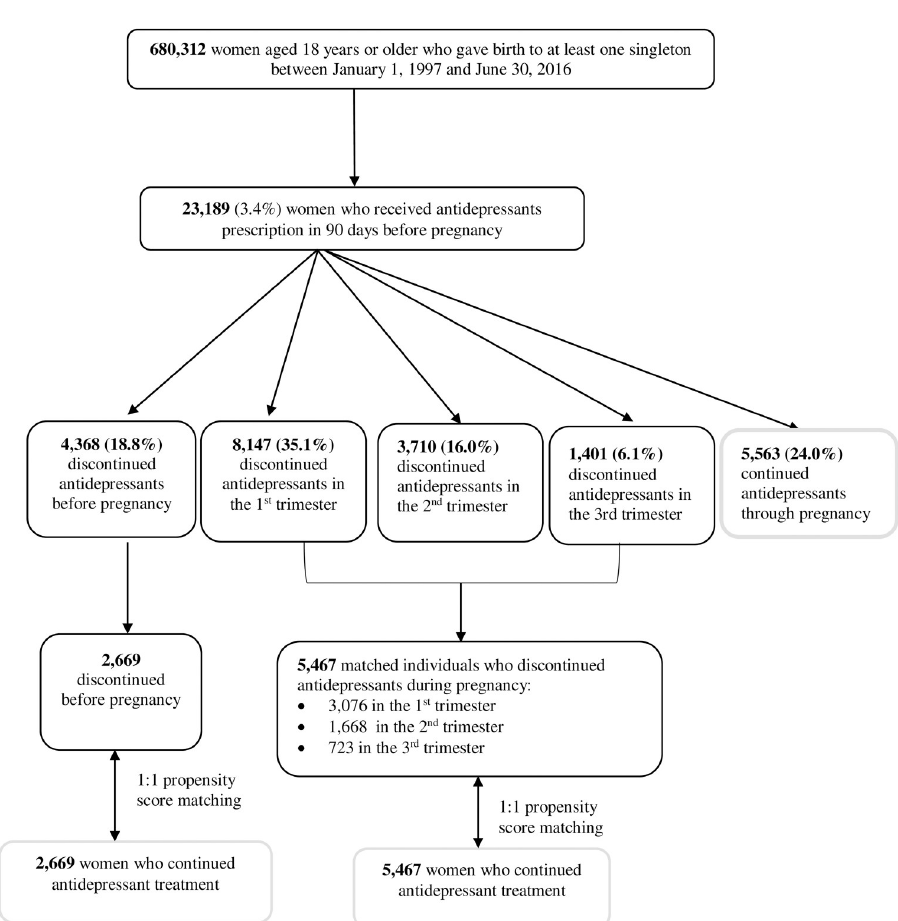
Fig 1. Flowchart illustrating the identification of study